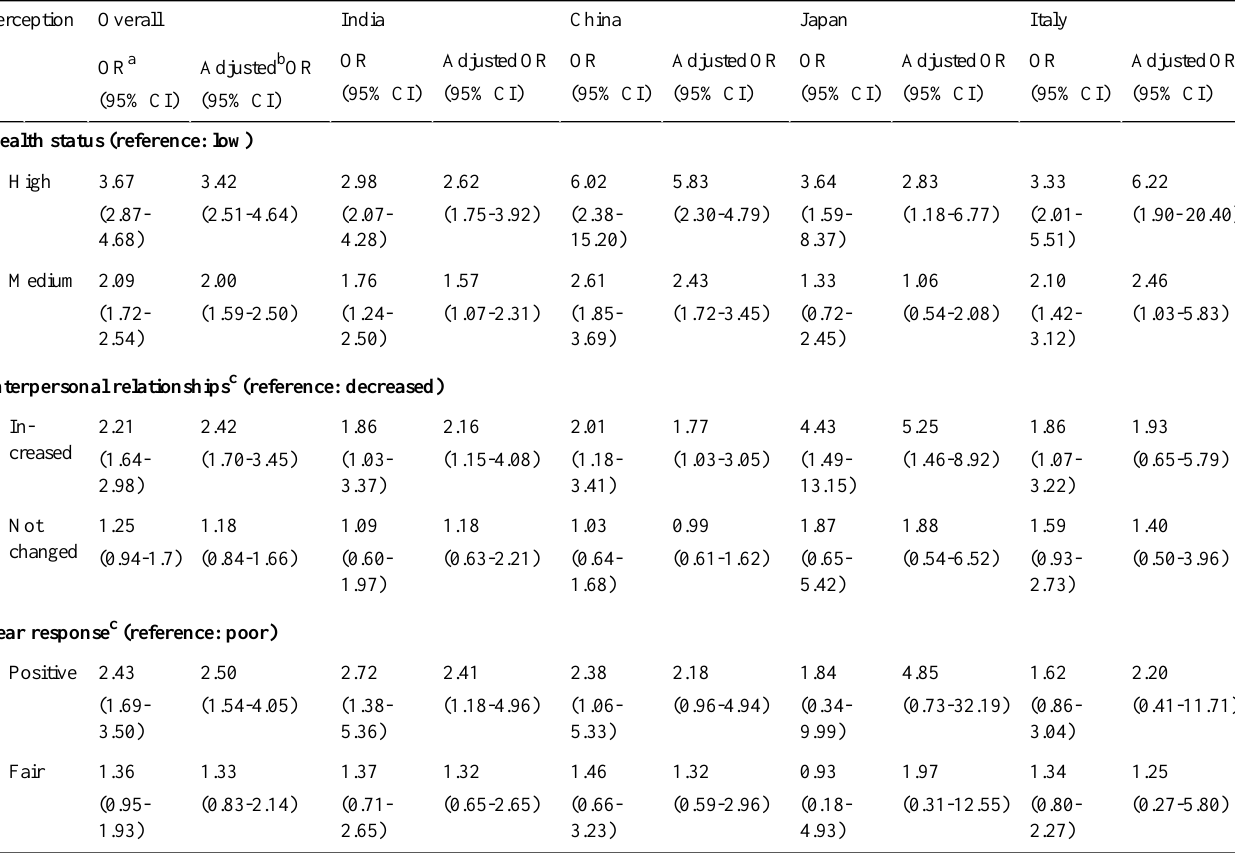
Table 4. Role of perceptions in the adoption of healthy lifestyle choices.